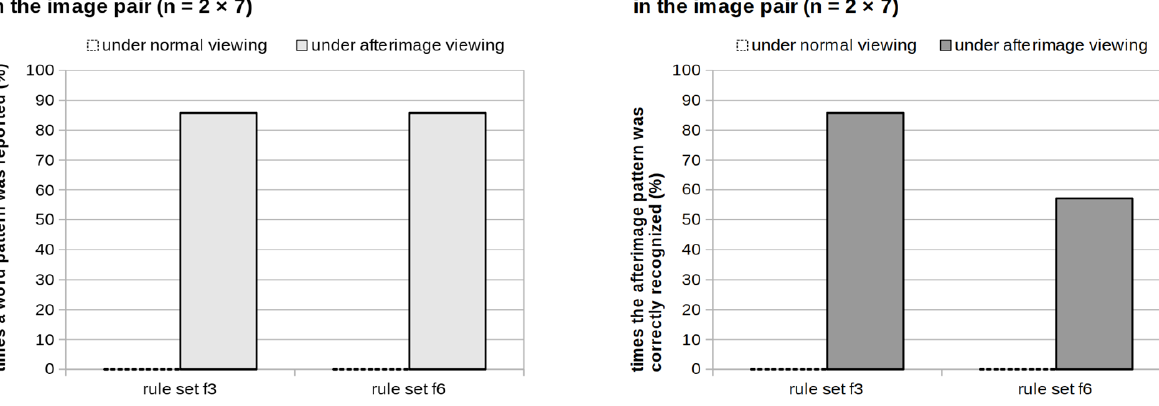
Figure 12. Results of the experiment: word shape recognition under normal viewing versus under afterimage viewing. Left and right: under normal viewing, none of the test subjects ever reported recognizing any word pattern, let alone the correct target afterimage patterns. Left: under afterimage viewing, only a single test subject did not report recognizing word patterns. This was the same test subject for both rule sets f 3 and f 6 . Right: all other test subjects correctly recognized the target afterimage pattern when using rule set f 3 .